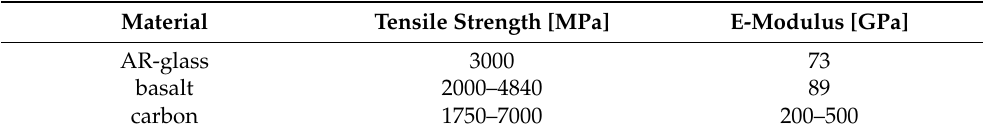
Table 1. Characteristics of the fiber raw materials (axial) [15].